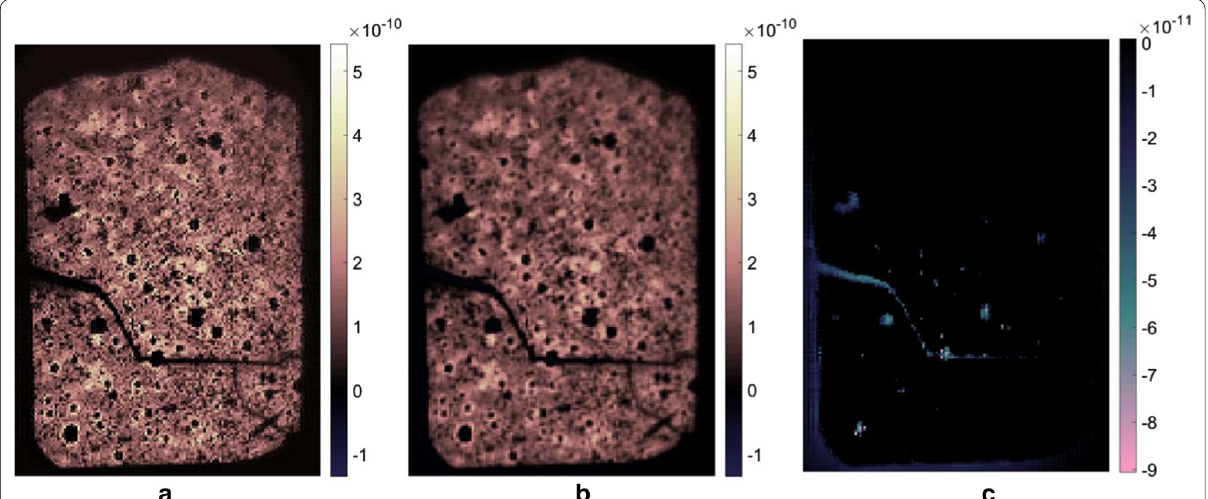
Fig. 13 A comparison of spatial and frequency domain inversion results for the Hawaiian basalt sample showing a the SIRM magnetic moments found using the TNT-NN unidirectional inversion (dipoles out of page) with 100 µ m dipole spacing, b the SIRM magnetic moments found using the Fourier technique of Lima et al. (2013) with 100 µ m dipole spacing, and c the Fourier solution where only the dipoles violating the non-negativity constraint (undershoot) are shown. The TNT-NN solution was obtained using an a 19.0 mm × 25.0 mm spatial domain and the Fourier solution was obtained using a 20.0 mm × 25.0 mm spatial domain. The cropped field of view for all images is 13.6 mm × 19.1 mm. All units are Am